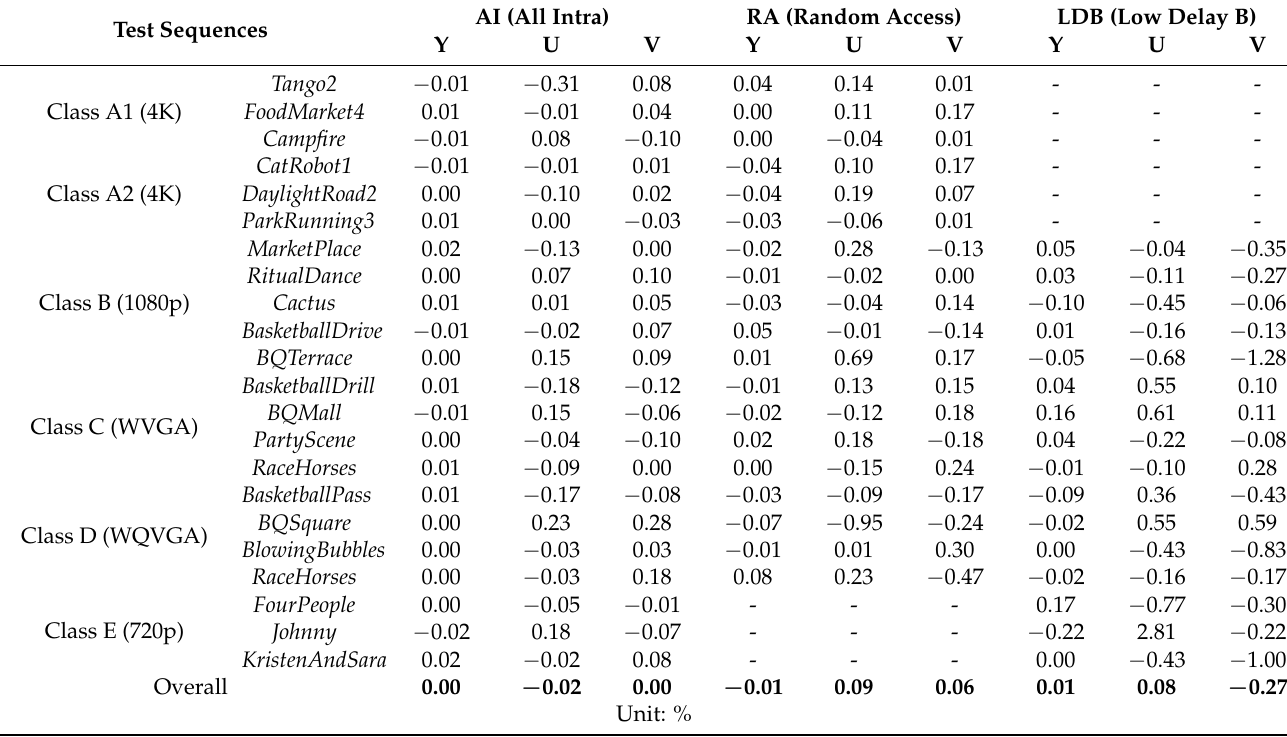
Table 2. Simulation